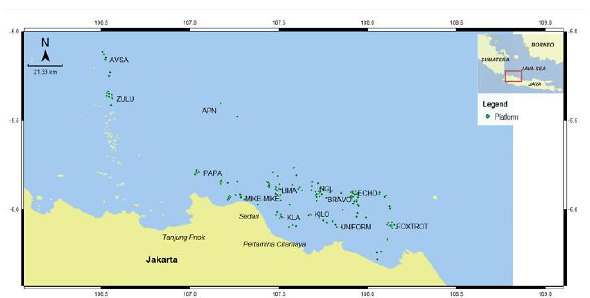
Figure 1. Locations of oil production fields in the south-western Java Sea.